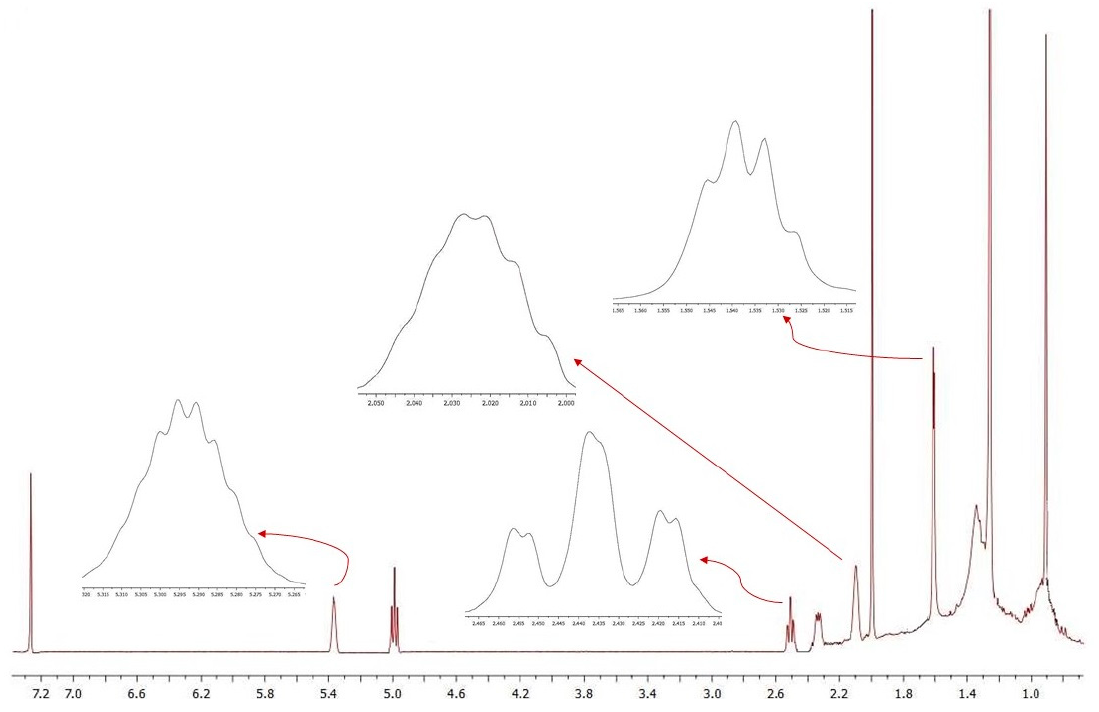
Figure 3. 1 H-NMR spectrum of F containing only ( E )-chrysanthenyl acetate.